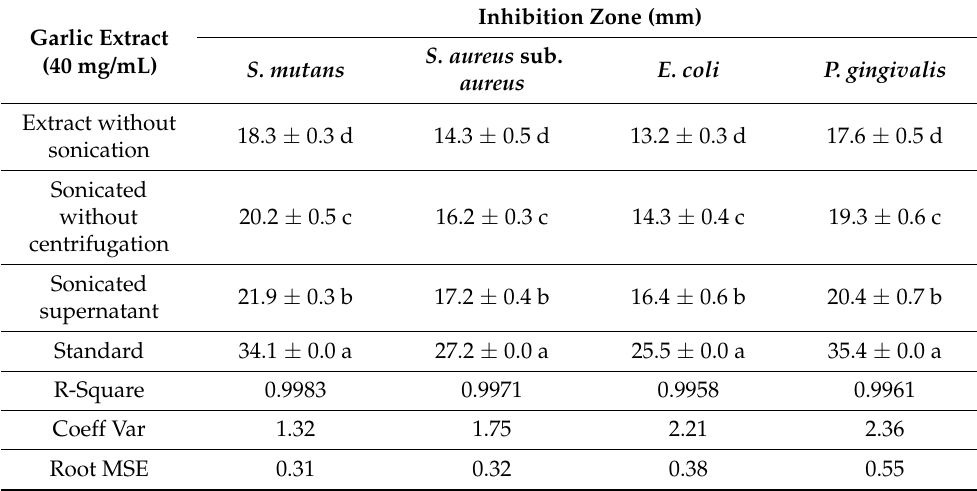
Table 4. Antibacterial activity of 40 mg/mL garlic extracts treated in different conditions by agar well diffusion